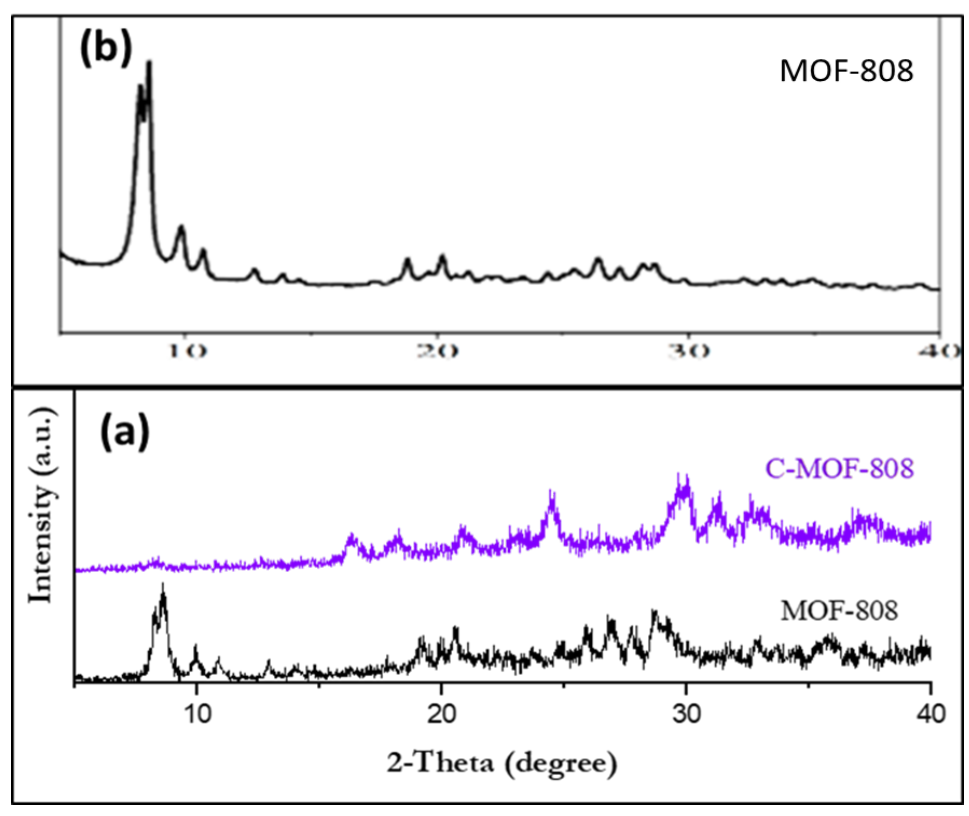
Figure 3. XRD patterns of ( a ) MOF and C-MOF-808; ( b ) reported XRD pattern of MOF-808 for comparison [46].